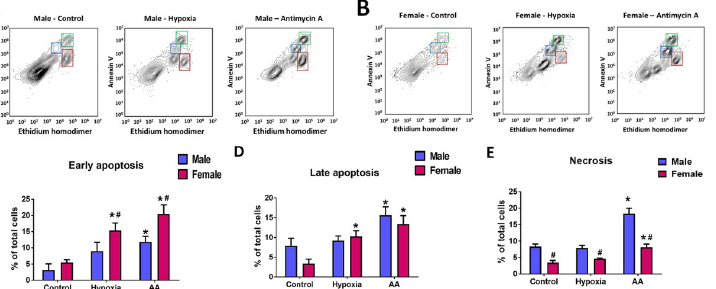
Fig 5. Distinct sex-specific profile of apoptotic and necrotic cell death in MLEC in response to stresses induced by hypoxia or mitochondrial dysfunction. The level of apoptosis and necrosis in male and female MLEC were measured in cells stained by Annexin V and Ethidium homodimer (EthD-1). A, B –representative plots showing populations of Annexin V and EthD-1 positive cells in Control MLEC and cells exposed to either hypoxia (24 h of 2% O 2 ), or Antimycin A (AA, 50 μ M for 24h). C-E– quantitative analysis of early apoptosis, late apoptosis, and necrosis in male and female MLEC. Values are means ± SEM. N = 4 repetitions from 5–7 mice isolated for each sex. � p < 0.05 versus same-sex Control cells; # p < 0.05 versus male MLEC. Statistical analysis was performed using the unpaired